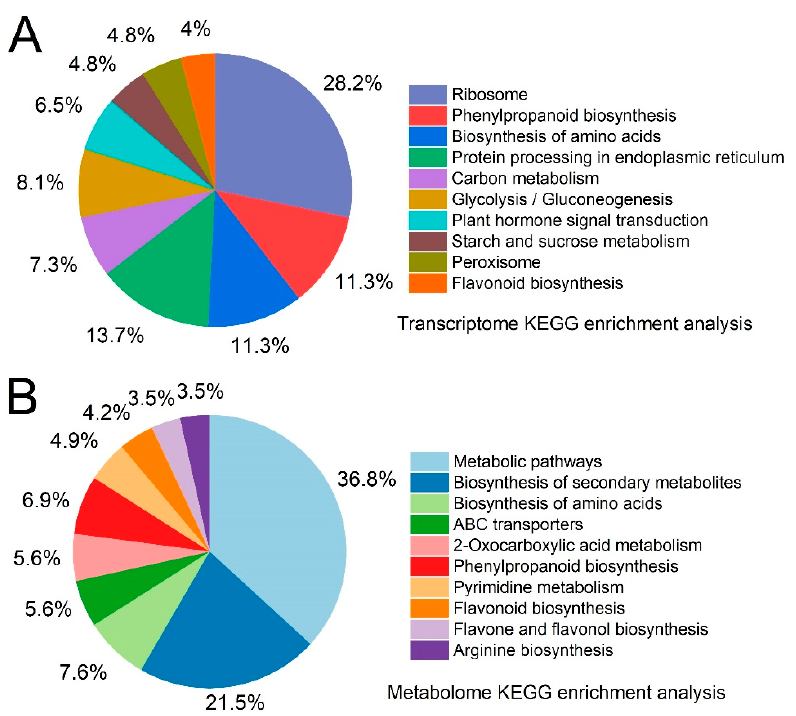
Figure 6. Enrichment analysis of the top 10 KEGG pathways associated with transcriptome and metabolome. ( A ) Transcriptome. ( B ) Metabolome. The percentage indicates the number of differential metabolites or differential genes/metabolites or genes annotated by the pathway enriched by the pathway.